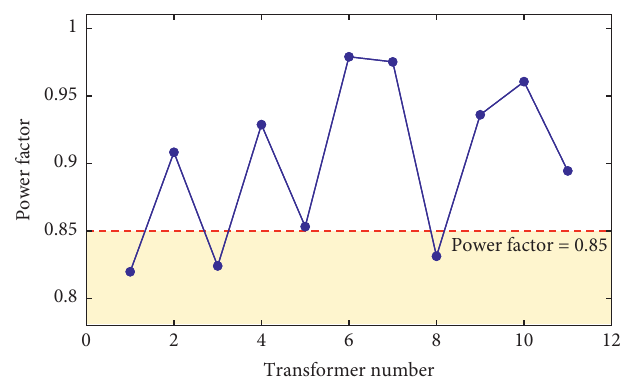
Figure 7: The power factor of each public transformer. Table 2: Individual loss reduction strategies (distribution line).